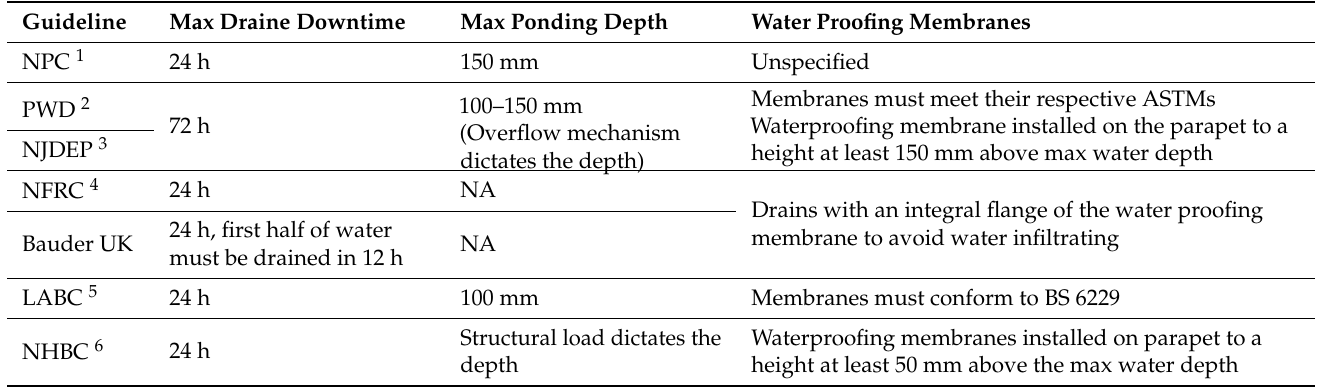
Table 3. Design requirements on SDA performance for storm-water management in Canada, the US, and the